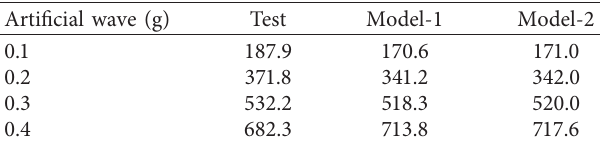
Table 9: Comparison of peak relative displacements of the top end of the bushing obtained by the test and simulation.